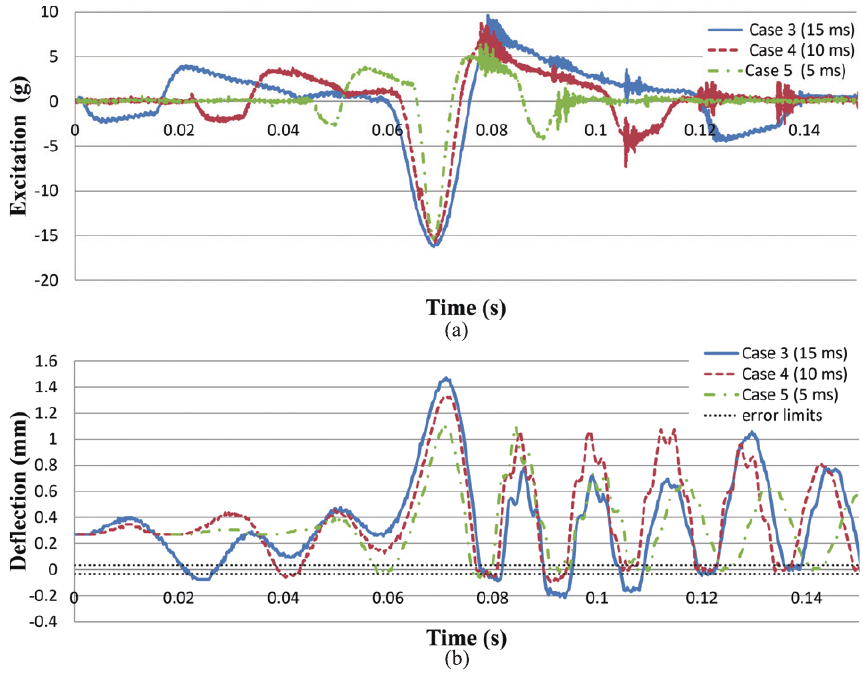
Fig. 4. (a) Excitation and (b) response when changing pulse